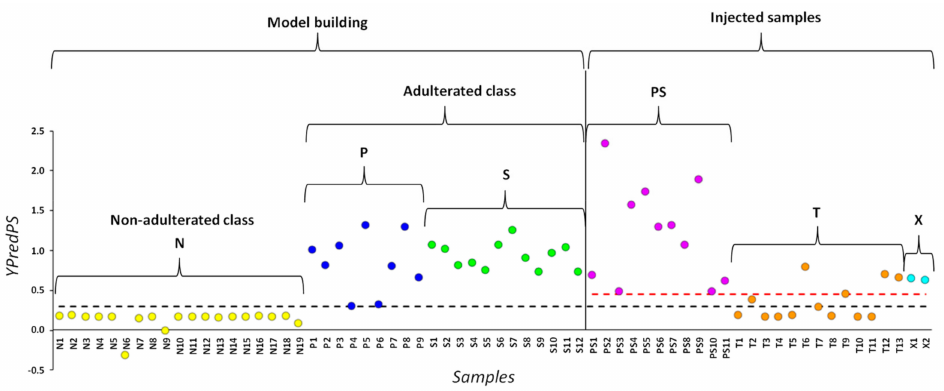
Figure 2. Predicted Y-values (YpredPS) obtained for the 66 DS analyzed based on the two-class PLS-DA model comparing natural samples (N) to adulterated samples (samples (P) and (S) considered together as a single class of adulterated samples). Samples above the red dashed line ( YpredPS = 0.45) are defined as adulterated and those below the black dashed line ( YpredPS = 0.30) as natural. PS, both sibutramine and phenolphthalein-adulterated group; T: test samples, i.e., newly purchased DS; X: atypical